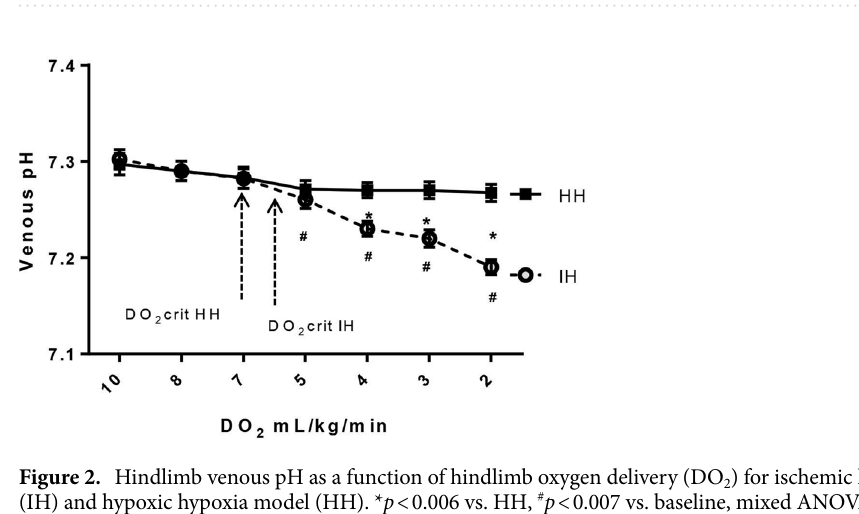
Figure 1. Hindlimb venous-to-arterial CO 2 content difference (ΔCCO 2 ) calculated with McHardy equation ( A ) and with Douglas equation (ΔCCO 2D ) ( B ) as a function of hindlimb oxygen delivery (DO 2 ) for ischemic hypoxia model (IH) and hypoxic hypoxia model (HH). * p < 0.006 vs. HH, # p < 0.007 vs. baseline, mixed ANOVA.